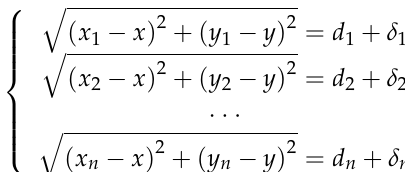
Figure 3. Constraint principle in ideal conditions.